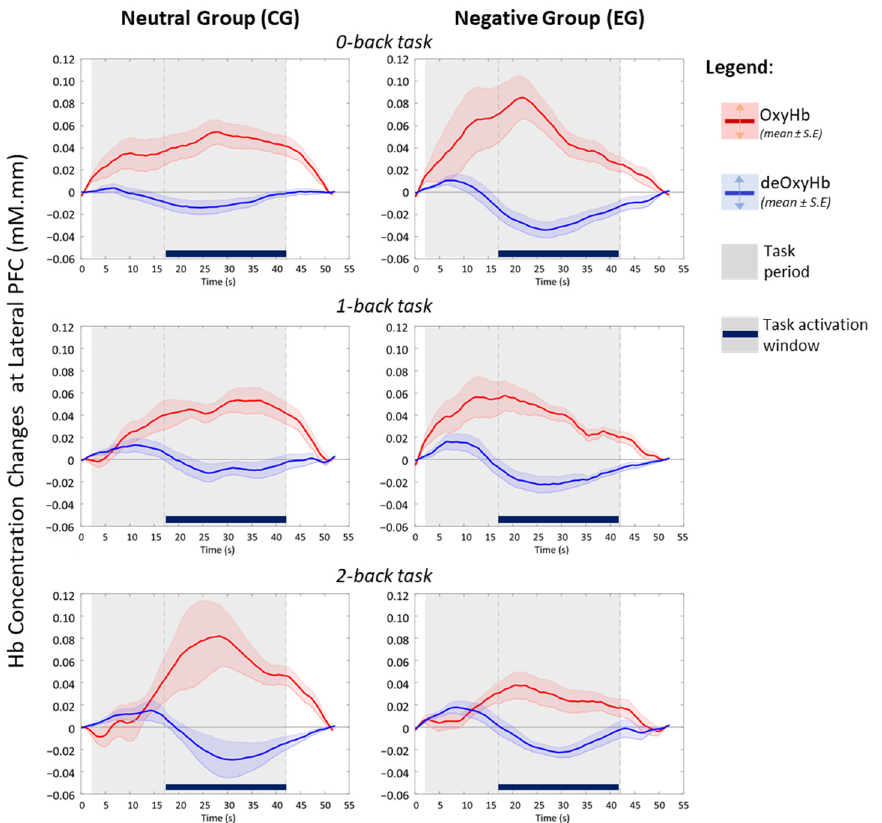
Figure 4. Averaged temporal haemodynamics from significant activated channels in LRPFC during n-back tasks (adapted from [57] with written permission).